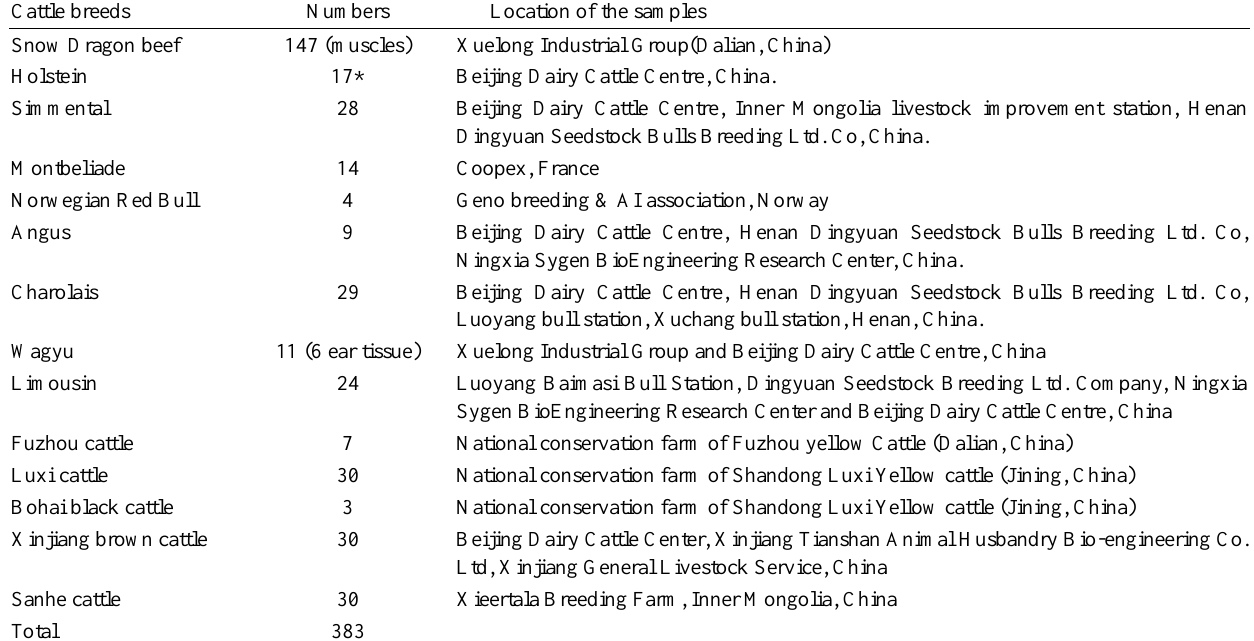
Table 1. Samples used in the study Cattle